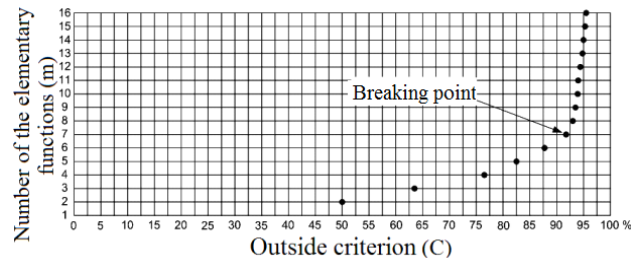
Fig. 4. Elimination curve of outside criterion